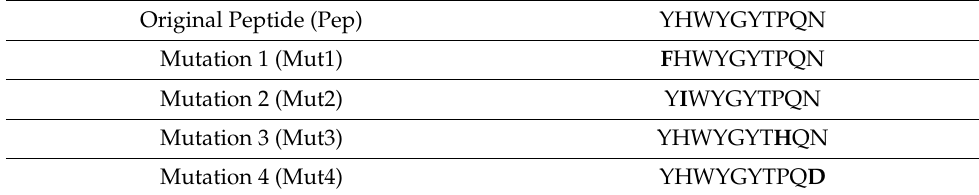
Table 1. Peptide